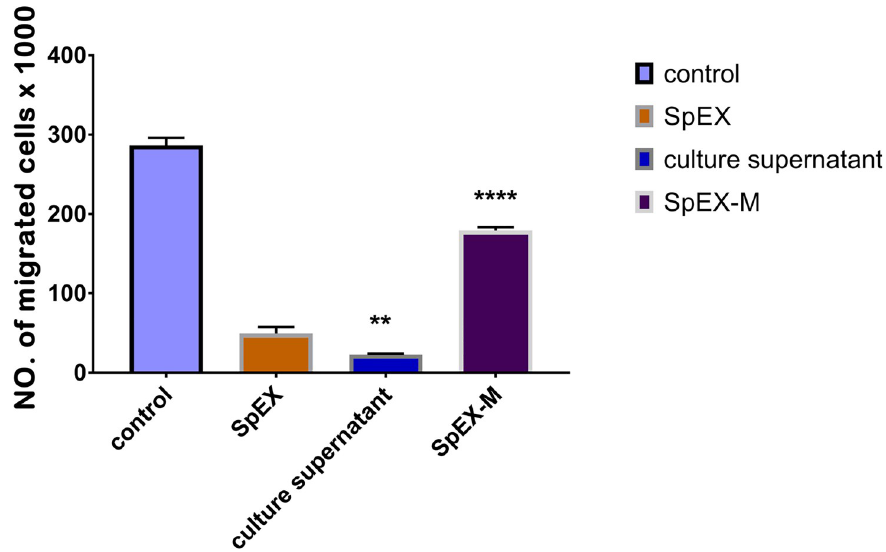
Fig 6. PMN transmigration assay. Recombinant SpEX at a concentration of 0.2 μ g /ml significantly inhibited the migration of PMNs induced by fetal bovine serum compared to SpEX-M at the same concentration with P < 0.0001 ���� . The chemotaxis inhibition by culture supernatant of S . pseudintermedius 06–3228 was significantly higher than SpEX P = 0.0035 �� . The values represent averages from three independent experiments. ( � P < 0.05 was considered significant). Data are plotted on the Y axis X